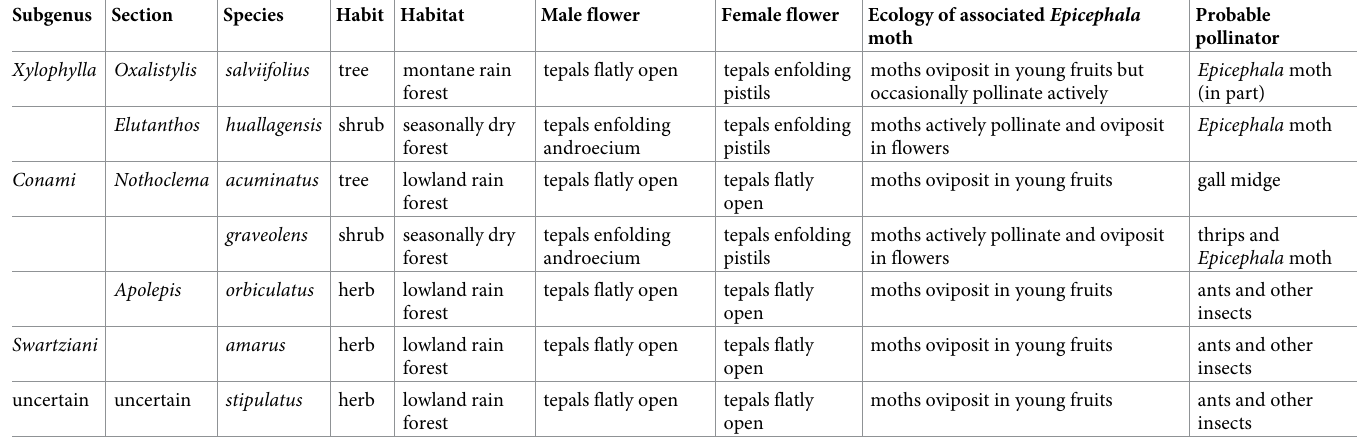
Table 3. Summary of the morphological and ecological characteristics of the seven studied Phyllanthus species. Subgenus